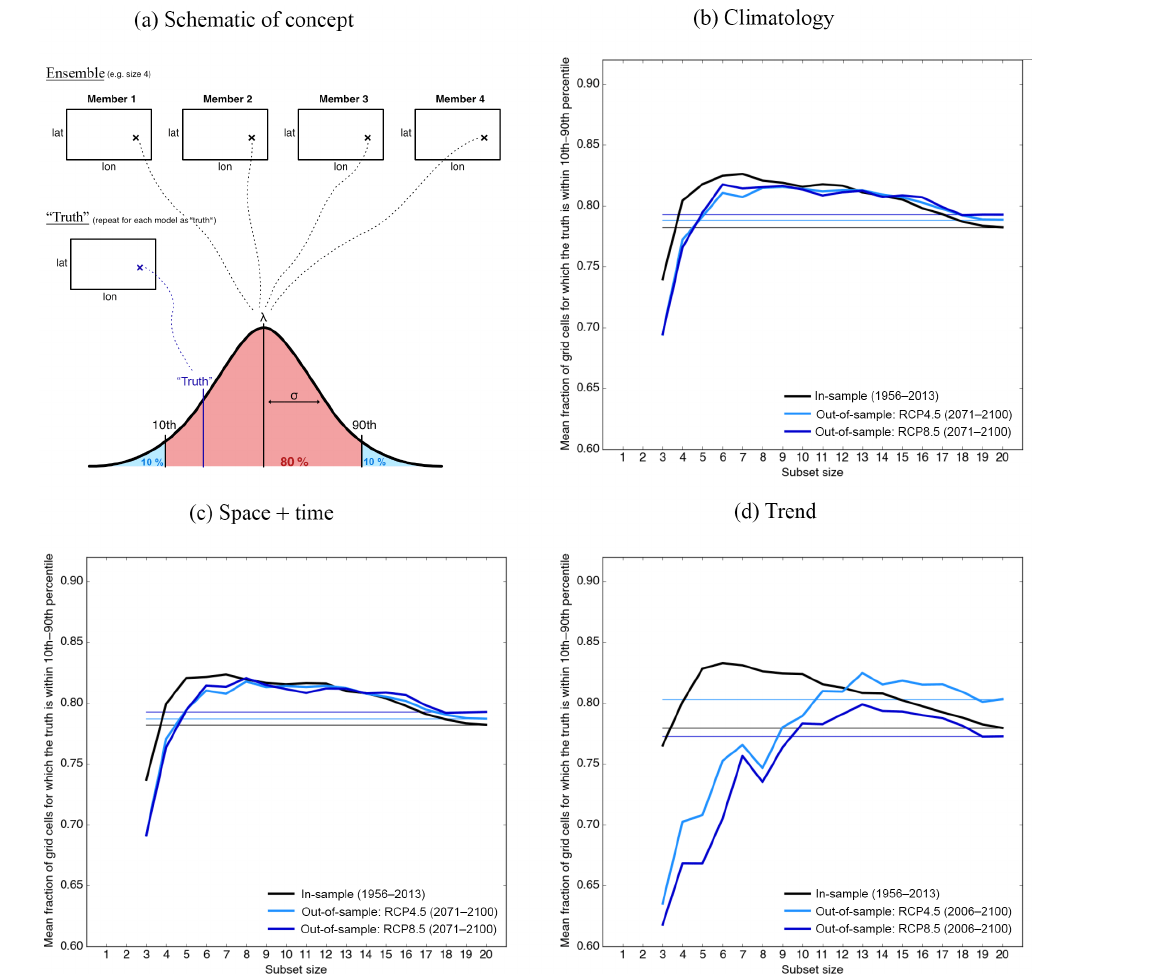
Figure 5. The number of times the “model-as-truth” is within the 10th–90th percentile of ensemble spread (defined by the optimal subset for a given size) averaged across all “truths” is plotted against the subset size. (a) Schematic explaining how the fraction of “truth” lying in the predicted range is obtained. (b) – (d) In-sample (black) and out-of-sample (blue) curves for three different metrics. Surface air temperature is used as the variable. The horizontal lines refer to the percentage obtained by using all 21 model